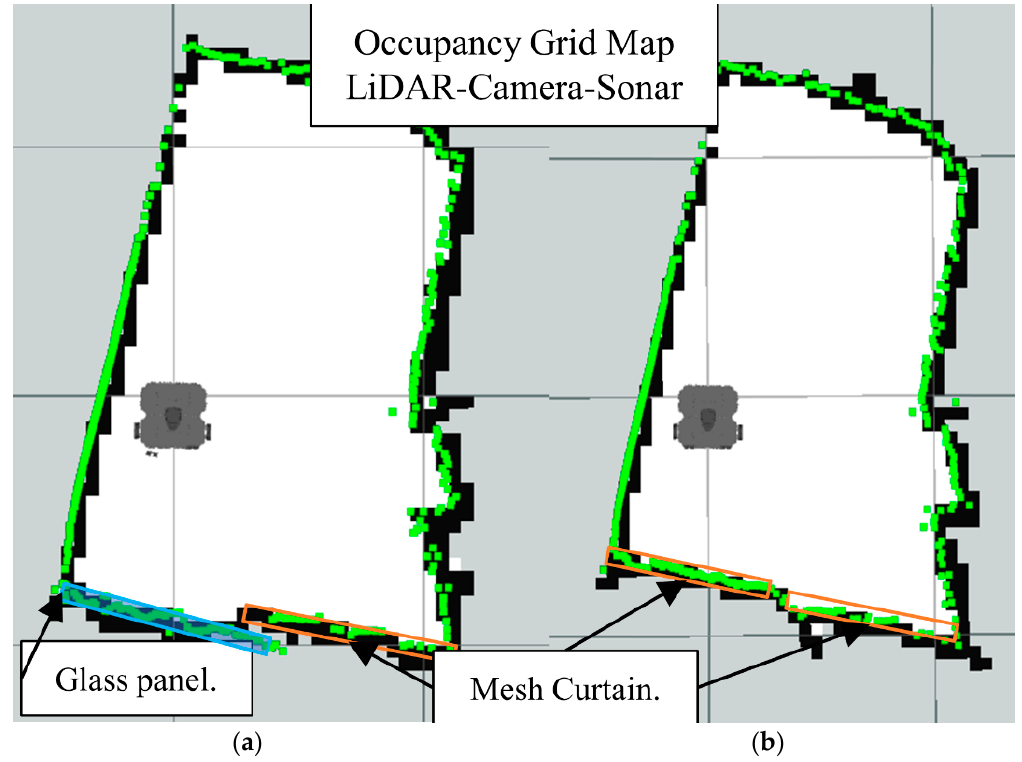
Figure 32. Occupancy grid maps showing the: ( a ) Ground truth (reference map); ( b ) LiDAR-Camara-Sonar fusion generated map with insect/bug mesh as main obstacle.